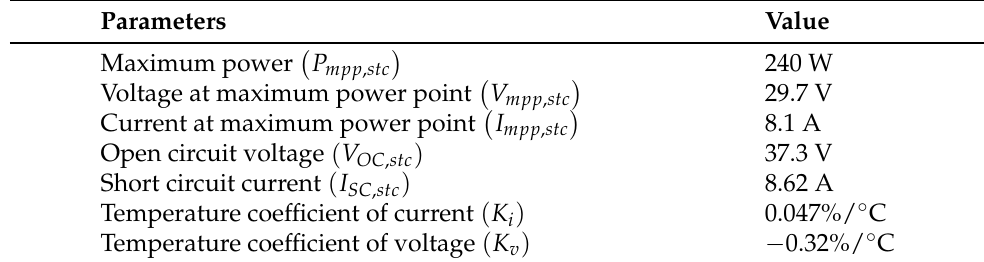
Table 1. Specification of PV module